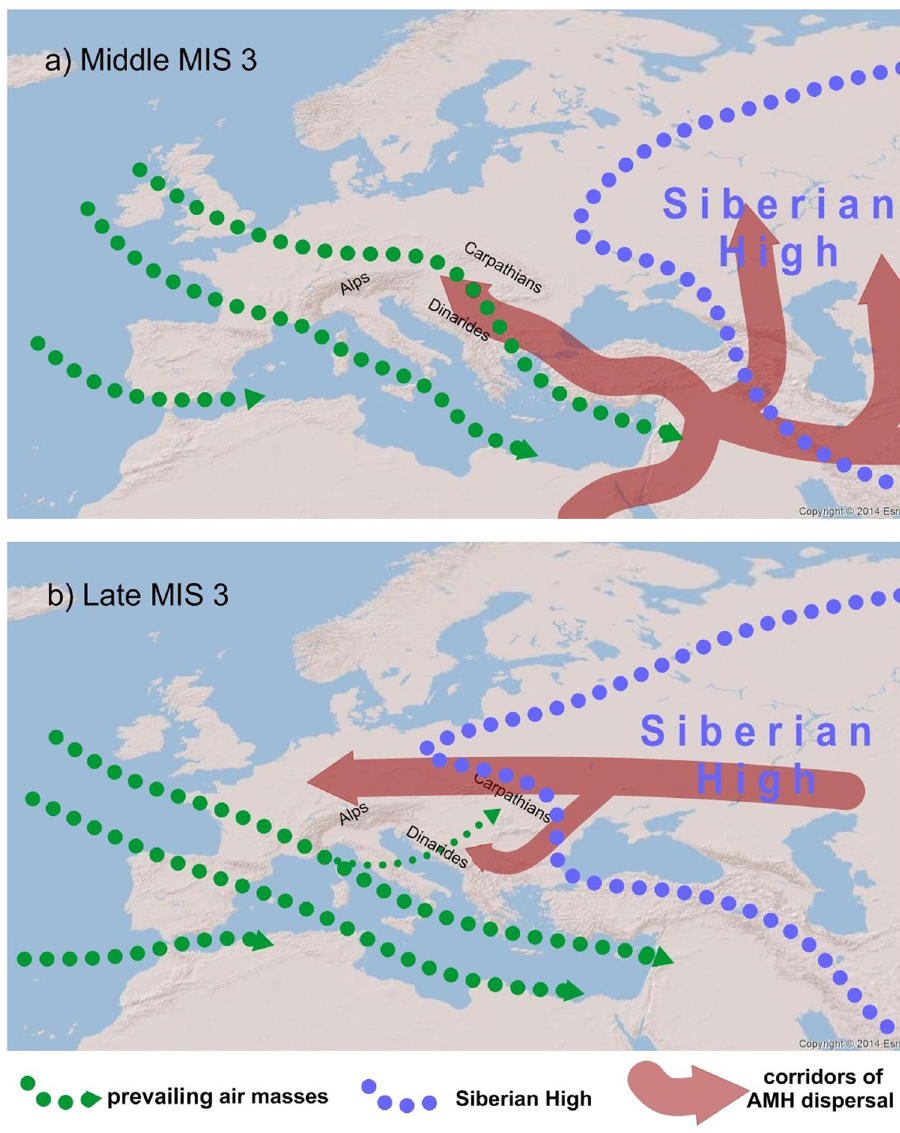
Figure 5. ( a ) Simplified scheme of proposed general atmospheric circulation patterns over Europe during middle MIS 3. Note that the Westerlies were reaching Central and Southeastern Europe via the NW-SE trajectory; (b) Simplified scheme of proposed general atmospheric circulation patterns over Europe during late MIS 3. Increase Siberian High influence on Europe had a major influence on Eastern and Western Europe, while the Westerlies shifted to the S-E trajectory, bringing the warmer air masses from the Mediterranean to the Balkans and the Middle Danube Basin. The blue line represents a schematic intensification of Siberian High, green lines show prevailing air masses and red lines represent paths of AMH dispersal in Europe. The map was generated using ArcGIS 10.2.2